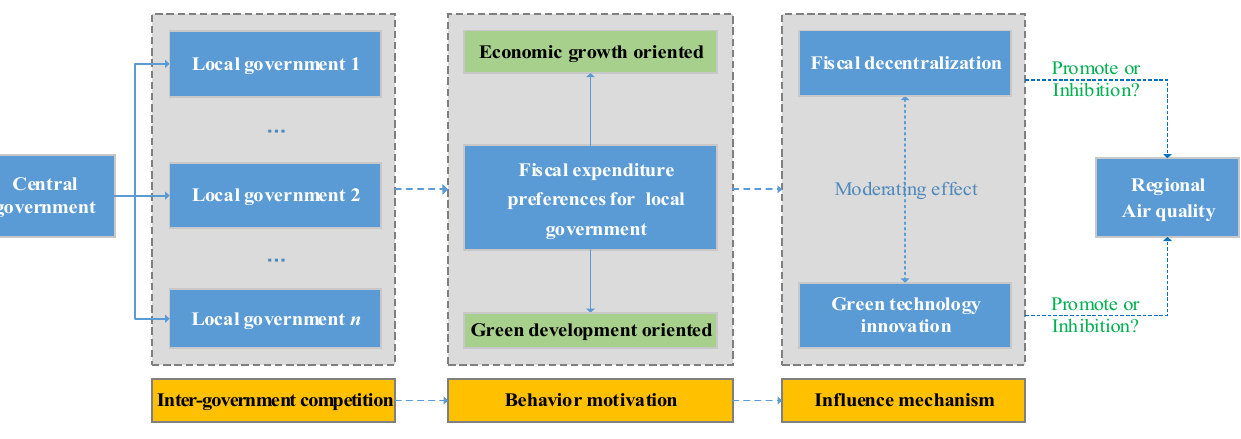
Figure 1. Research framework.